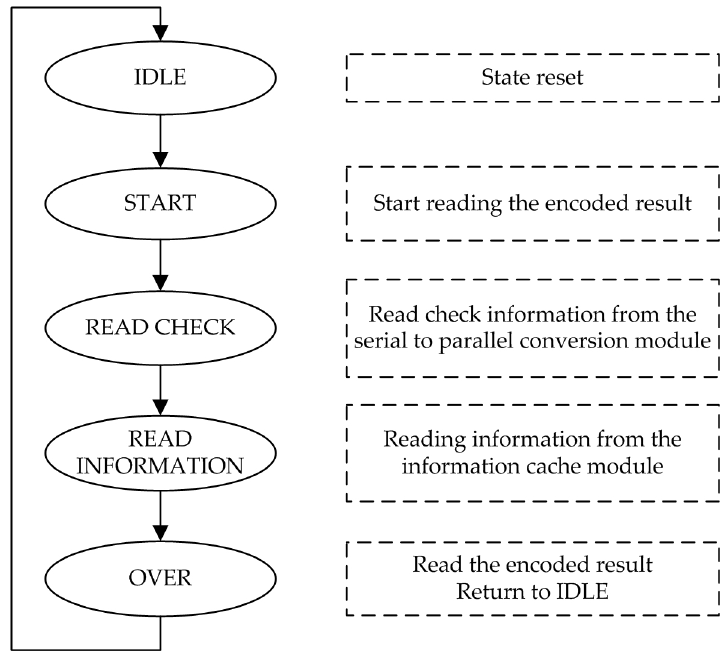
Figure 8. The state machine of the output module.